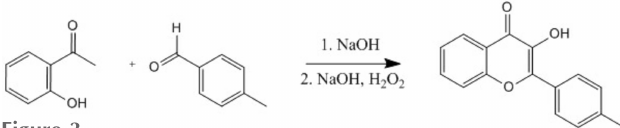
Figure 3 Synthesis of the title compound.